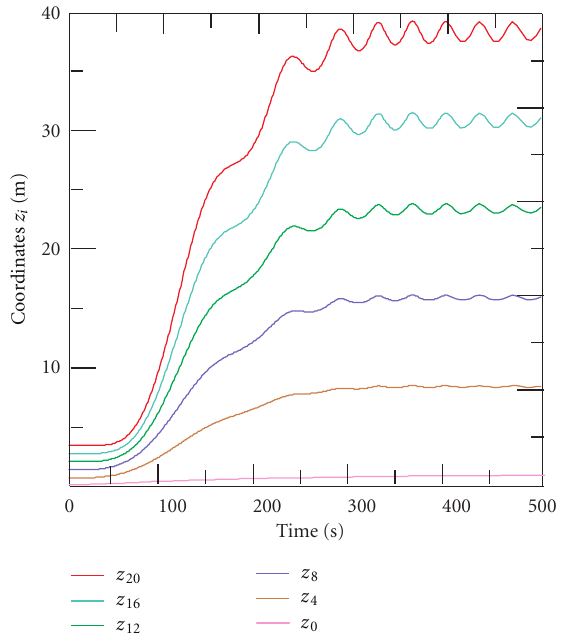
Figure 14: General coordinates z i versus time at optimal deploy- ment law.